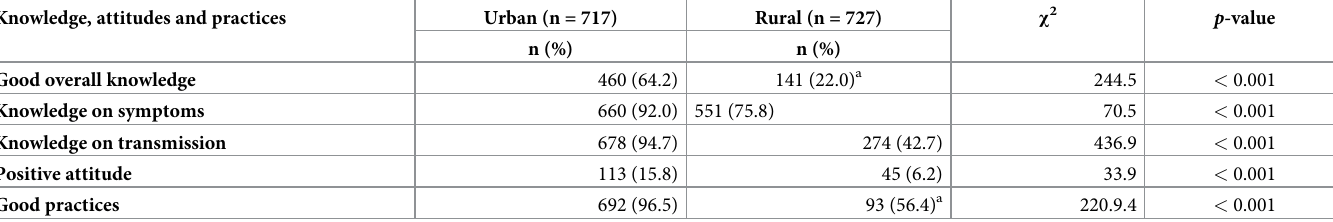
Table 2. Association between residence and knowledge, attitudes and practices regarding